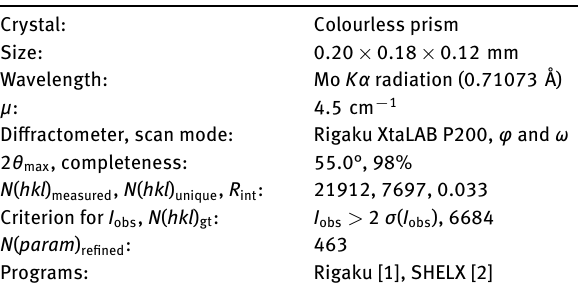
Table 1: Data collection and